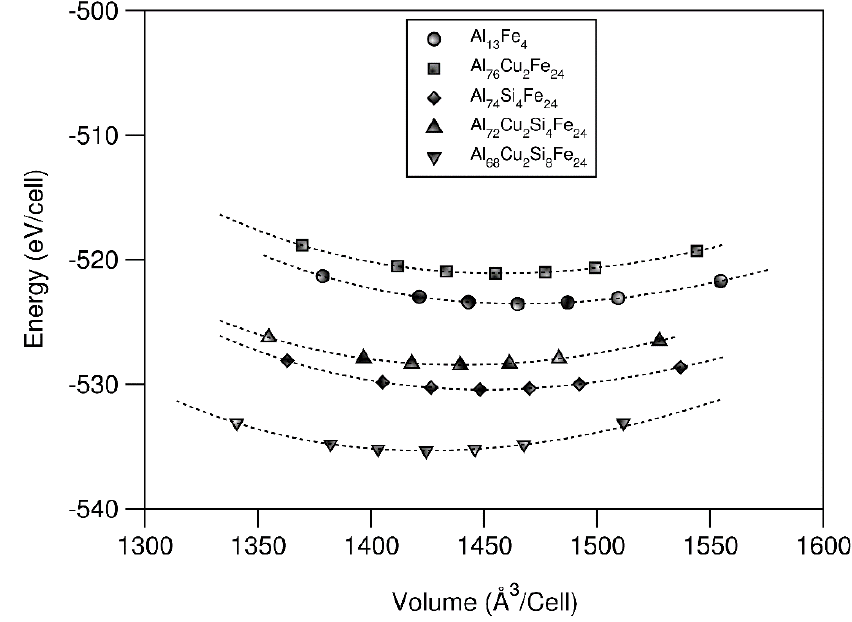
Figure 5. The relationships between the total valence-electron energies on the cell volumes. The dotted lines represent the fitting according to the Murnaghan equation of states [50,51]. Table 4. The obtained results for the related configurations using the Murnaghan equation of state. V 0 represents the optimized volume, E 0 the energy, B 0 the bulk modulus and B 0′ the first derivative. The formation energies (Δ E form ) with respects to the elemental solids according to Equation (3) also included.